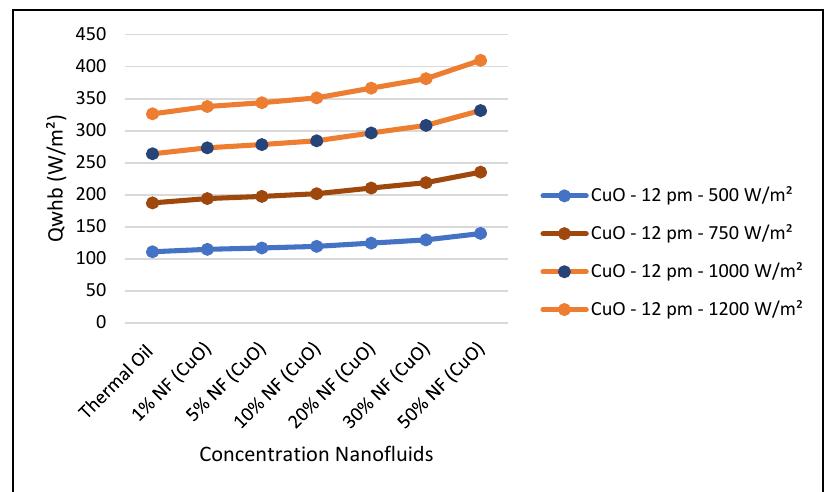
Figure 29. CSP system hybrid waste heat boiler thermal energy at CuO nanofluid and different concentrations.